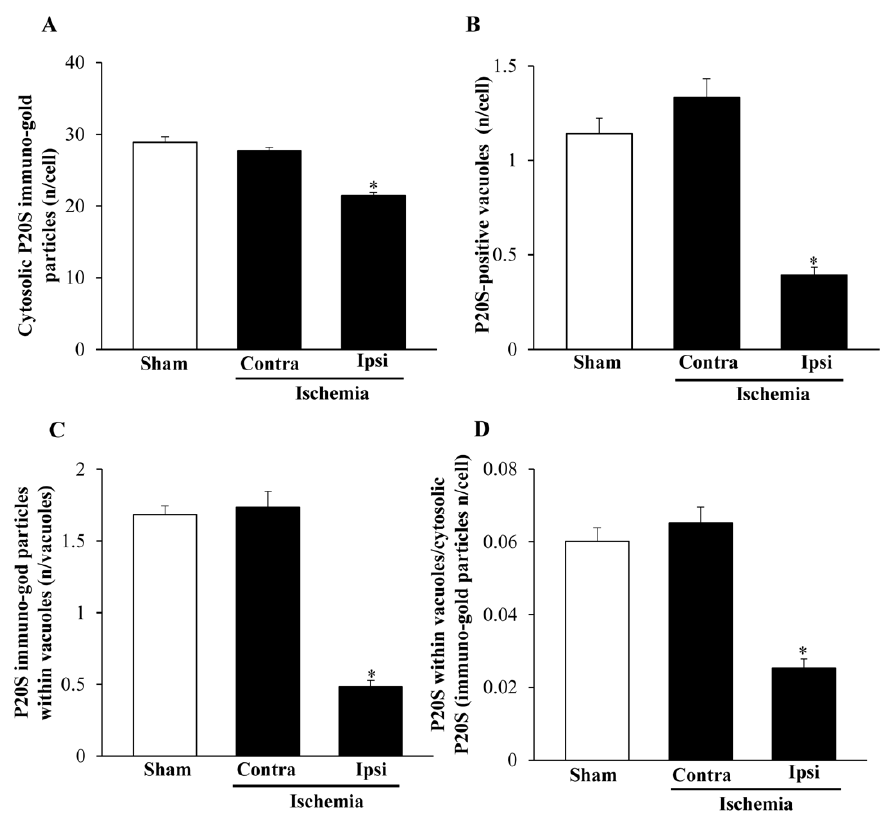
Figure 14. Ultrastructural morphometry P20S within ventral regions. Graphs report the ultrastruc- tural morphometry for P20S from ventral area penumbra (Ipsi/Ischemia, n = 6) and homologous regions from the contralateral side (Contra/Ischemia, n = 6) or from sham-operated mice (Sham, n = 6). Values were reported as the mean ± S.E.M. per cell from a total of 120 cells for each group. * p ≤ 0.05 compared with other groups. ( A ) df = 2, F-value = 43.562, p < 0.0001; ( B ) df = 2, F-value = 40.712, p < 0.0001; ( C ) df = 2, F-value = 84.252, p < 0.0001; ( D ) df = 2, F-value = 36.64, p < 0.0001.